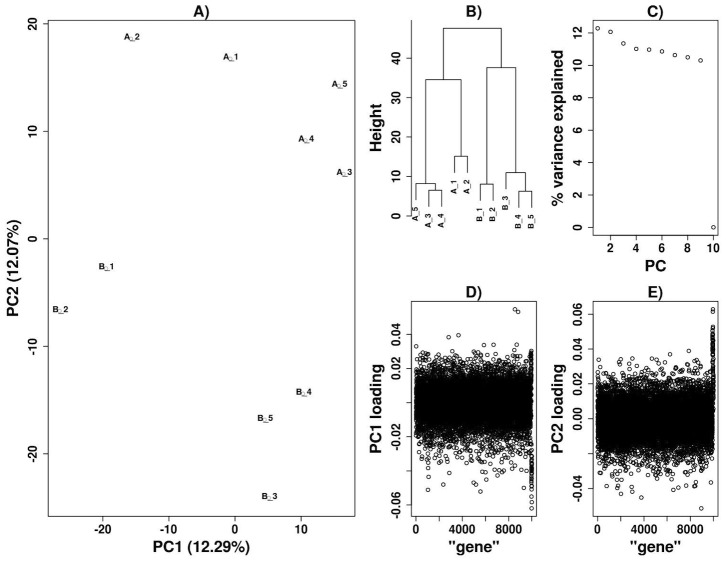

disPCA of ten simulated diseases.The p-values for ten diseases were simulated for 10,000 genes (Materials and Methods). Class A diseases had p-values uniformly distributed between 0 and 0.05 for 40 of the 10,000 genes, while two diseases from class A (A_1, A_2) and two diseases from class B (B_1, B_2) had p-values similarly distributed for a separate set of 40 genes (Materials and Methods). All other genes had p-values that were randomly distributed in each disease between 0 and 1. A) The simulated data is displayed on PC1 and PC2. PC1 separates (A_1, A_2, B_1, B_2) from all other diseases, while PC2 separates class A diseases from class B diseases. B) Dendrogram derived from a clustering analysis based on the Euclidean distance between datasets in the space of the first two PCs (represented as the height of the branches). C) PC1 and PC2 account for a similar amount of variance. D) Loadings for each gene are displayed sequentially for PC1. The 40 genes contributing to pleiotropy between the two diseases in each class (displayed as the last 40 genes) are enriched for larger absolute loadings. E) Similar to (D), with loadings for PC2 displayed. A separate set of 40 genes contributing to correlation between diseases in each class are also enriched for larger loadings.